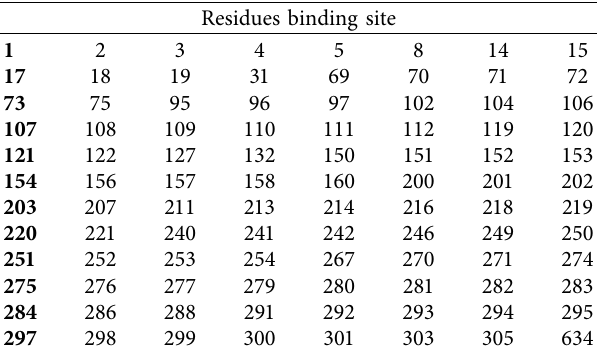
Table 1: Residue binding site of protease enzyme of SARS-CoV 2 (PDB ID: 7L11) which is calculated using Maestro Schrodinger.